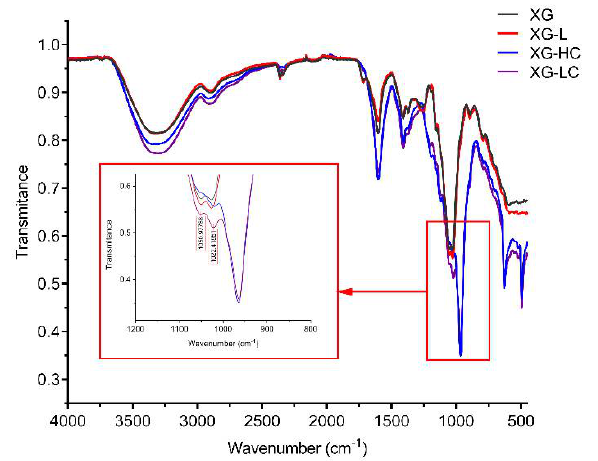
Figure 3. Fourier-transform infrared spectra of XG, XG-L, XG-HC, and XG-LC. XG, natural xanthan gum; XG-L, pyruvate-free xanthan gum; XG-HC, natural xanthan gum with a deoxidizer and glyoxal added; XG-LC pyruvate-free xanthan gum with a deoxidizer and glyoxal added.